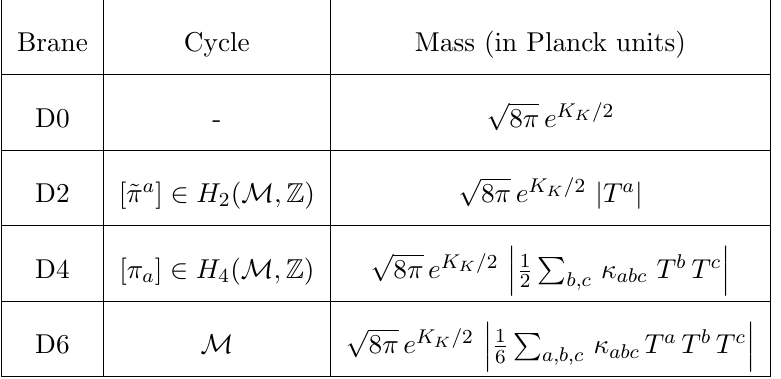
Table 3. Masses of the di(cid:11)erent particles obtained by wrapping one kind of D p -brane around a given even cycle on the Calabi-Yau